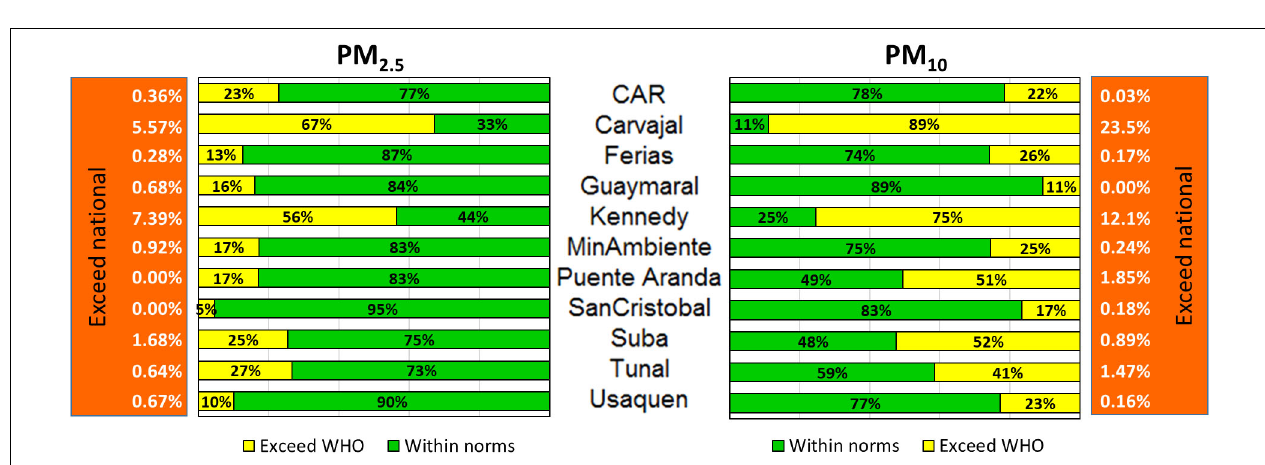
FIGURE 9 | Percentages of days during which the average daily concentration of PM 2 . 5 (left chart) and PM 10 (right chart) exceeded the WHO and the national reference values.